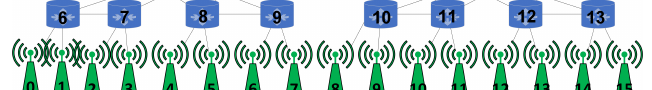
Figure 5. Simulation